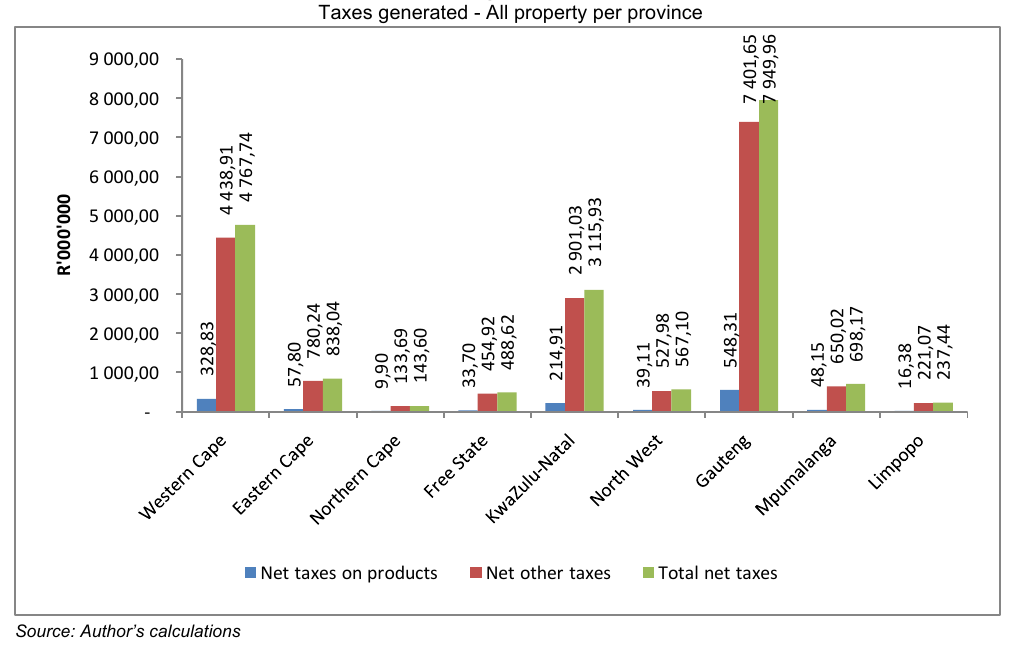
Figure 23 Taxes generated - All property per